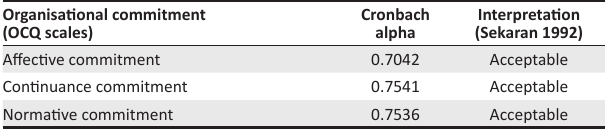
TABLE 5: Cronbach alpha scores, OC - Allen and Meyer (1990) organisation commitment research instrument